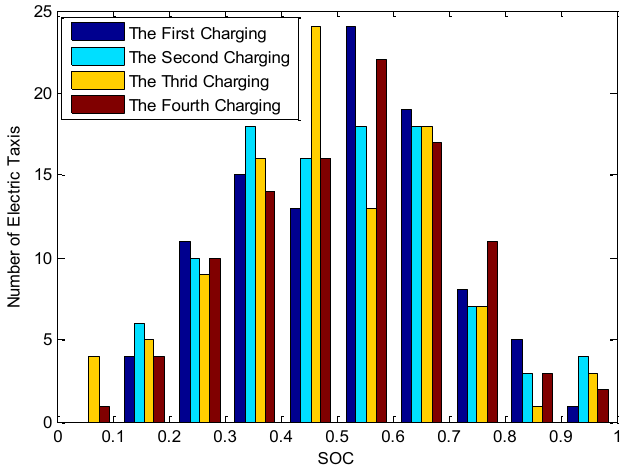
Figure 6. SOC distribution when electric taxis return.